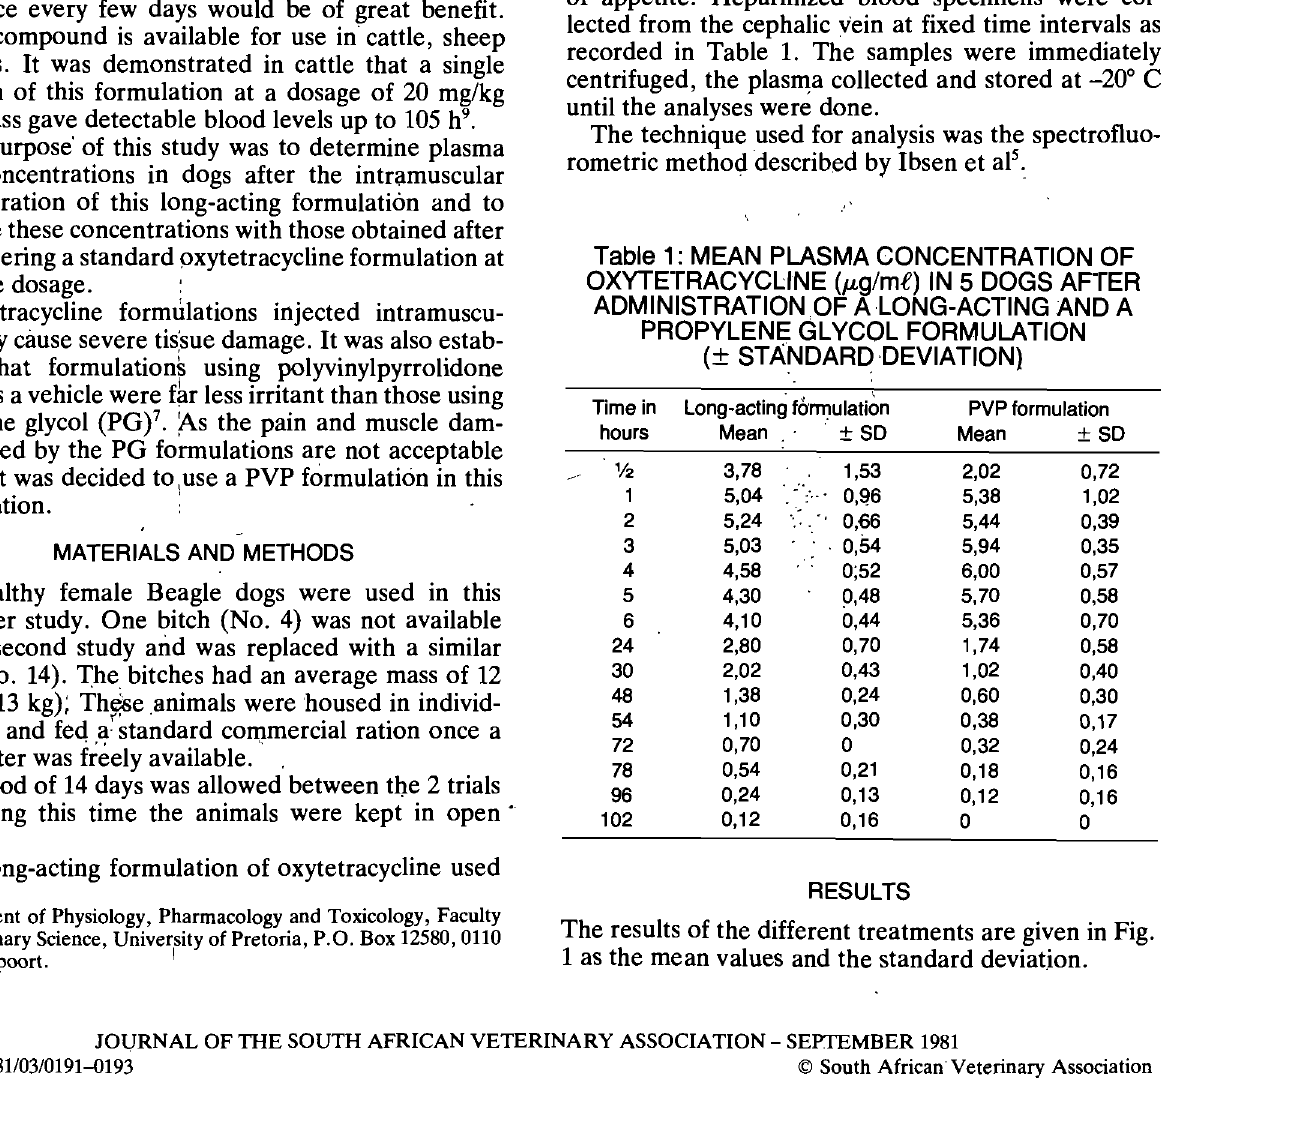
Table 1: MEAN PLASMA CONCENTRATION